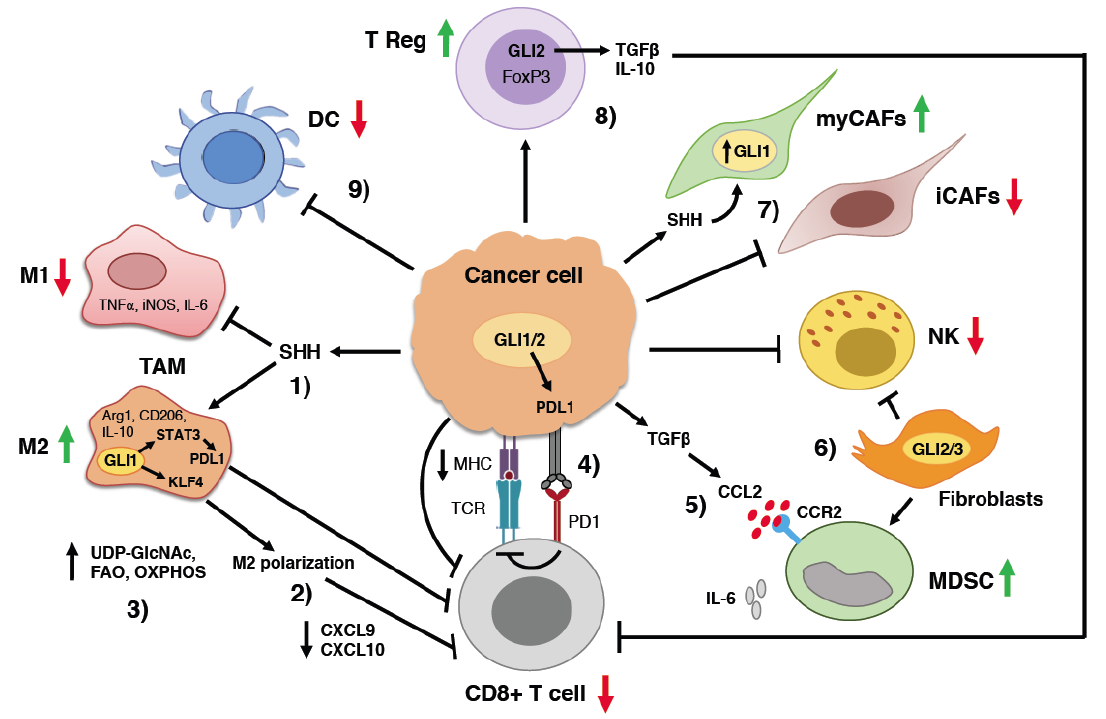
Figure 2. Impact of HH signaling on the immune tumor microenvironment. The HH pathway is active in cancer cells and in several other cell types present in the tumor microenvironment, including TAM, T Reg and fibroblasts. (1) Cancer cells release SHH, driving the polarization of M2